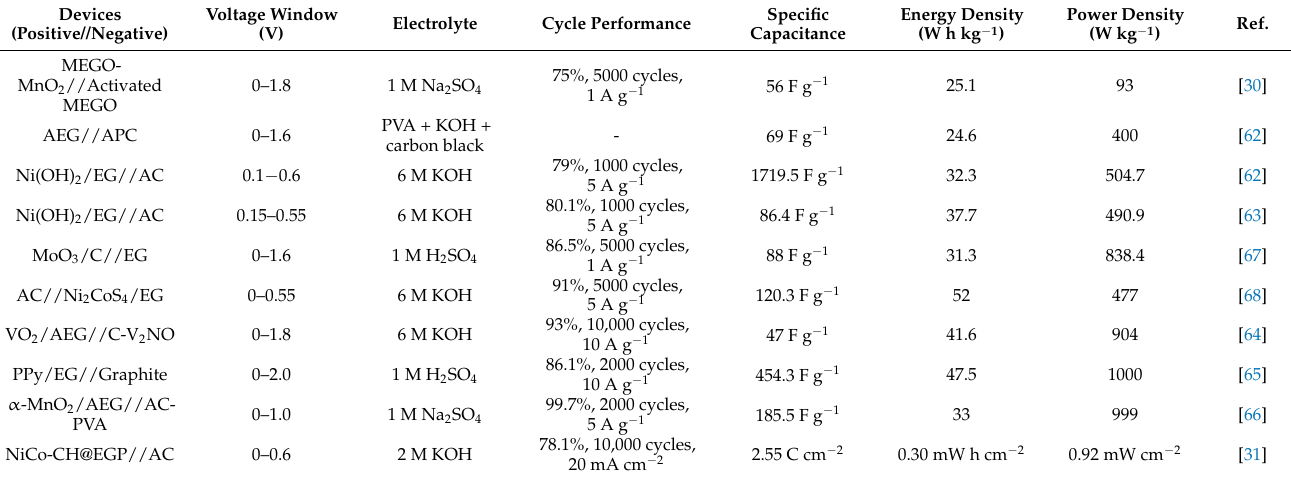
Table 2. Summary of asymmetric supercapacitor using EG-based materials as electrode